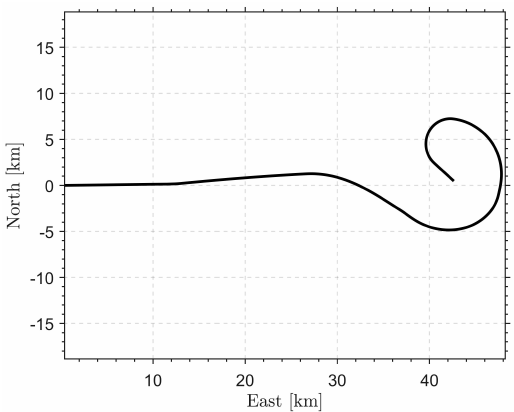
Figure 29. Flight trajectory of the flight mission.